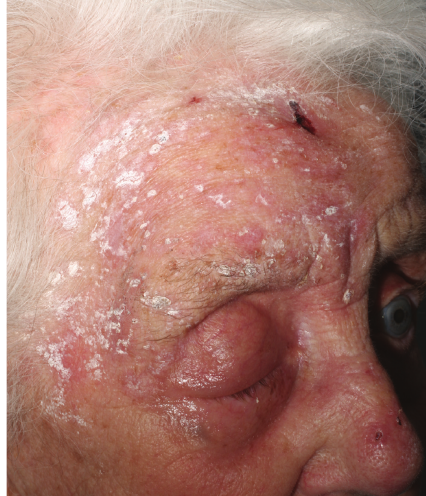
Figure 2: To show the rash in the distribution of the ophthalmic branch of the trigeminal